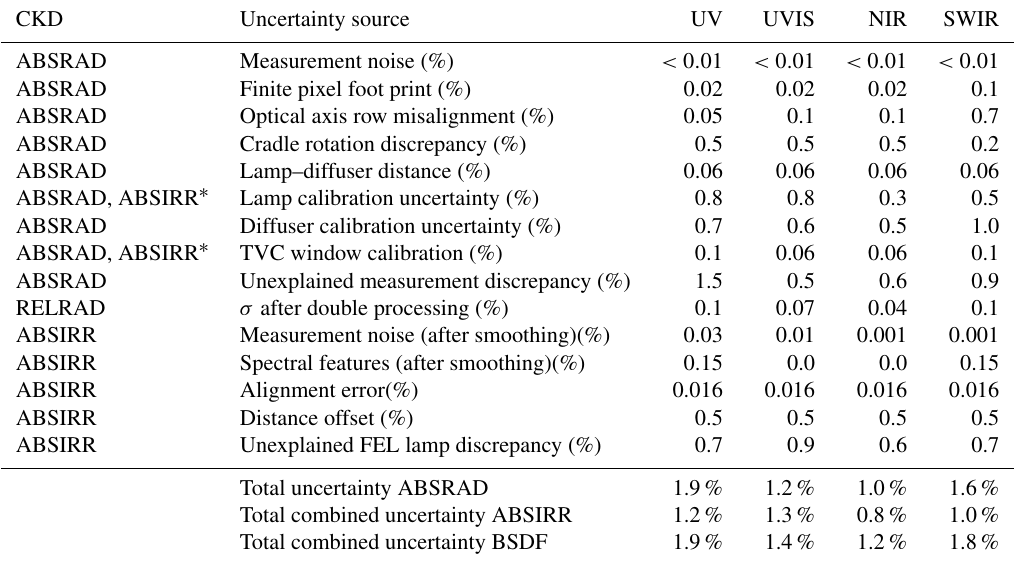
Table 6. Summary of the relative standard uncertainty components per detector for the ABSRAD, RELRAD, ABSIRR CKD, and ensuing instrument BSDF. The quantities marked with ∗ are not part of the BSDF calibration uncertainty because they cancel out. The uncertainties in this table only reflect the CKD errors; the final error in L1b products is calculated using these and all other CKD in the processing chain; see also the discussion on L01b error propagation in Sect. 3.2. Note that set-up straylight cannot be reasonably estimated and might be included in the components “Unexplained FEL lamp discrepancy” and “Unexplained measurement discrepancy”. This error budget excludes the known issues with the stimuli, which can not be quantified due to the lack of independent validation measurements. The reported uncertainty is therefore potentially underestimated. The total 1 σ uncertainty was obtained by quadratically adding each individual